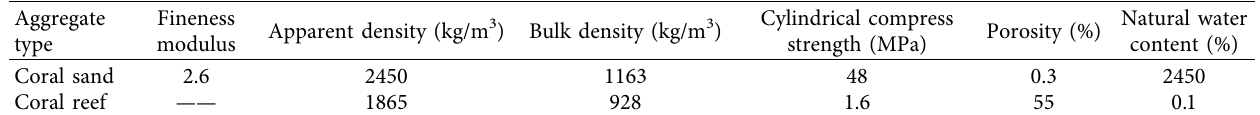
Figure 1: Coral aggregate and sand. (a) Coral coarse aggregate. (b) Coral sand. Table 1: Physical properties of coarse and fine aggregates.